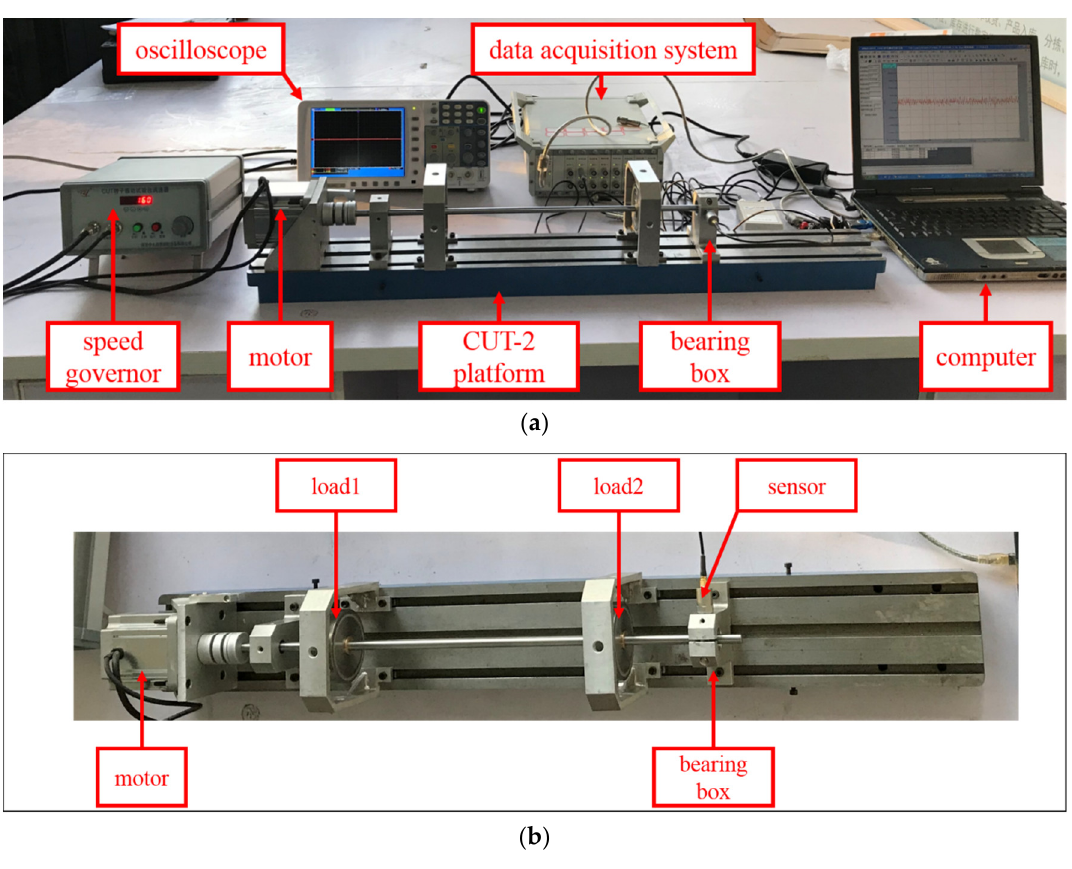
Figure 4. Experimental test rig: ( a ) CUT-2 data acquisition system; ( b ) CUT-2 platform.